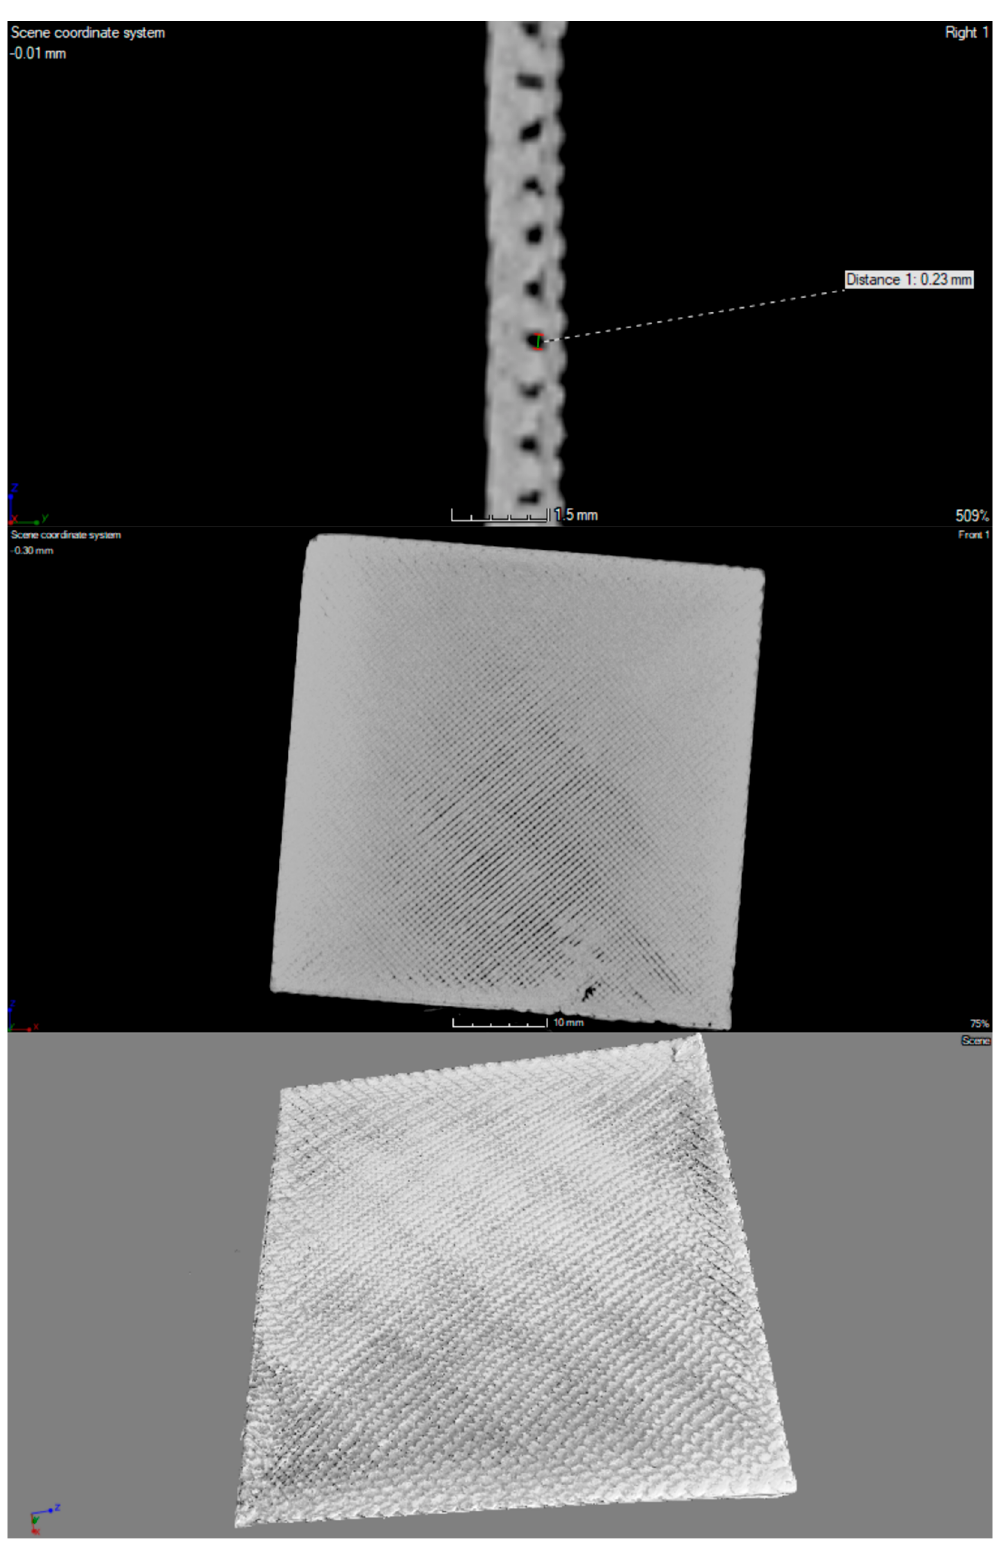
Figure 5. Micro CT imaging of 3D printed porous standard plate modified with rhodamine B derivative .